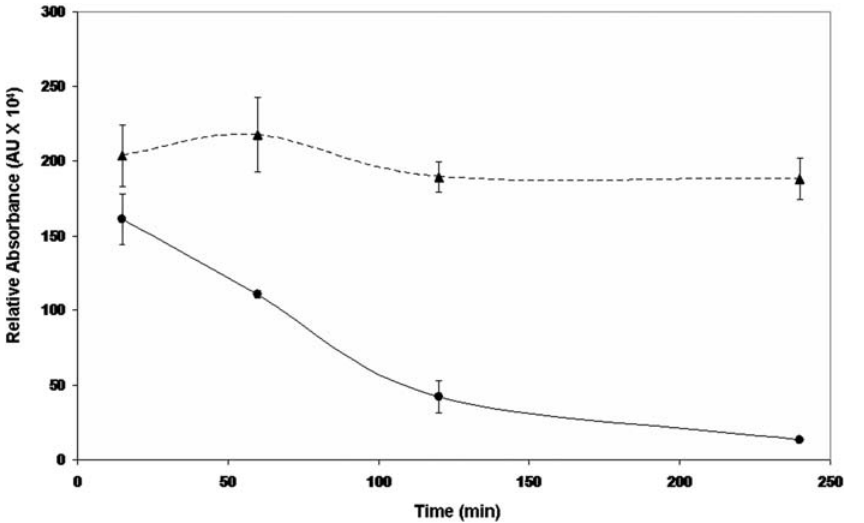
Figure 6. Mitochondrial lactate metabolism. Mitochondria from CCF-STTG1 cells were isolated and incubated with 5 mM lactate, and 0.1 mM NAD + for varying time intervals within the presence or in absence of 10 mM oxamate. Relative lactate levels were measured by HPLC. N =mitochondria in the absence of 10mM oxamate. m =mitochondria in the presence of 10mM oxamate. n=3; SD